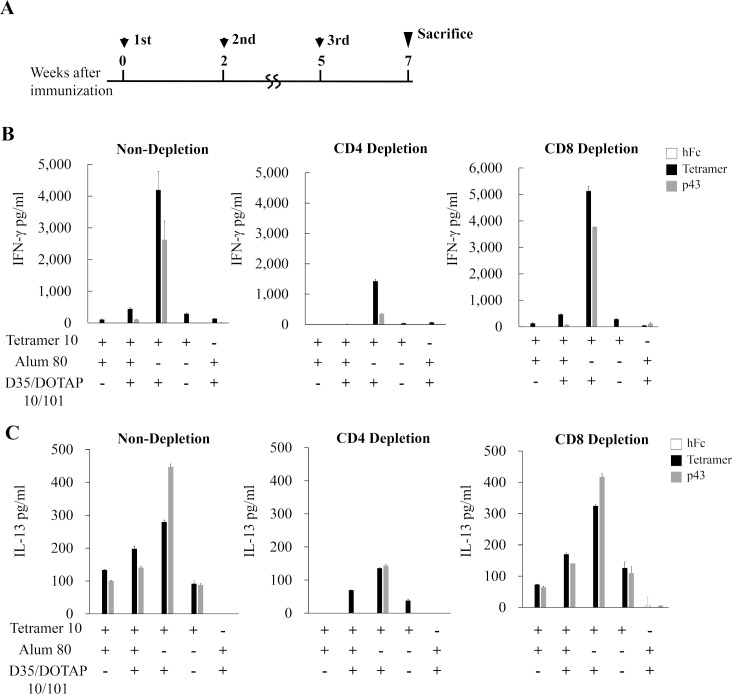
Cell type responsible for the cytokine induction.(A) Immunization schedule indicated as the weeks of immunization of four-week-old female BALB/c mice (n = 3). At the seven weeks after the third immunization, single cell suspensions were prepared from the mouse spleens after the hemolysis of red blood cells was conducted and continued for the depletion of the indicated cell type. The productions of IFN-γ (B) and IL-13 (C) in supernatant were detected by ELISA assays.